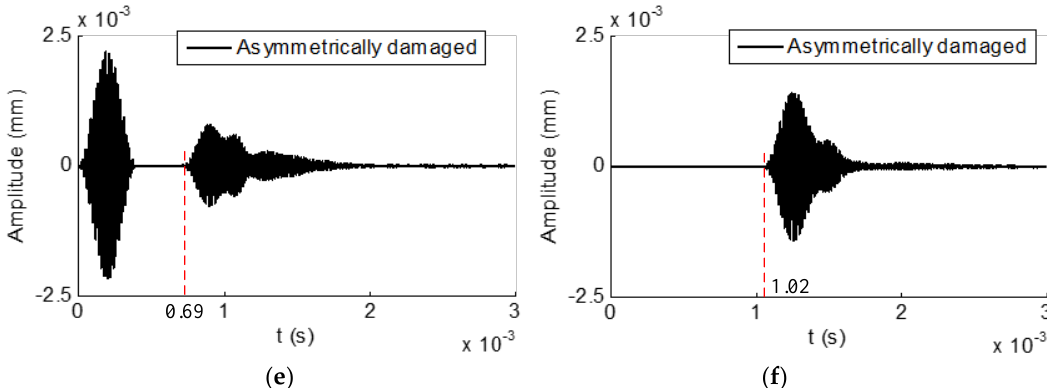
Figure 16. Time domain waveforms received from hexagonal drill pipes under the excitation of circumferential surface traction generating T(0,1) mode at the center frequency of 50 kHz: ( a ) and ( b ) reflected and transmitted waves from a normal hexagonal drill pipe, respectively; ( c ) and ( d ) reflected and transmitted waves from a symmetrically damaged hexagonal drill pipe, respectively; and ( e ) and ( f ) reflected and transmitted waves from an asymmetrically damaged drill pipe, respectively.